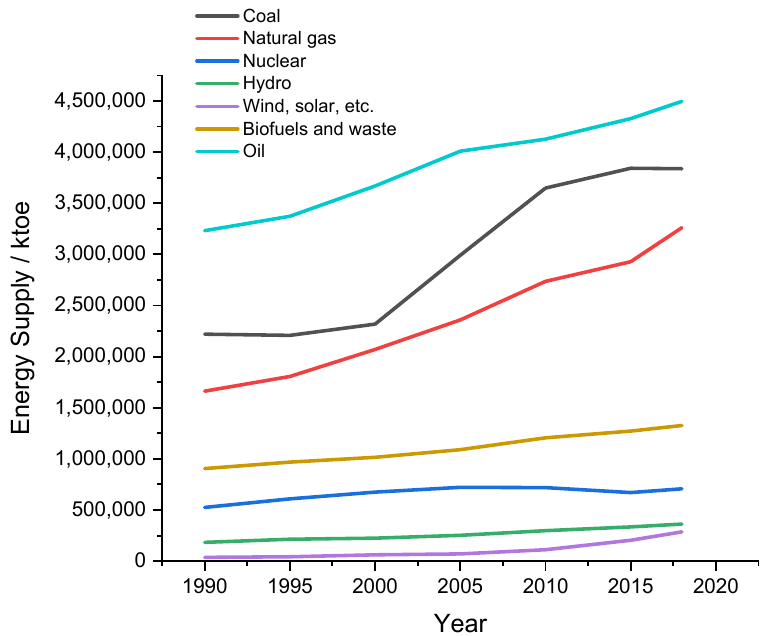
Figure 1. Energy supply source share in the last 30 years. Based on International Energy Agency, IAE, data from IEA (2021) [Energy Supply by Source], https://www.iea.org/data-and-statistics (accessed on 16 September 2021), All rights reserved; as modified by the Authors of the present paper.